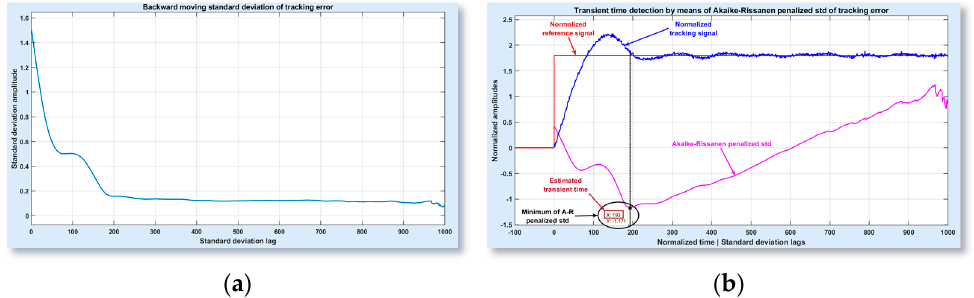
For the signal in Figure 5, σ b ε is displayed in Figure 6a. At the right side end, the std of final tracking error is computed, whereas the larger values obtained at the left side end correspond to the first values of tracking error.